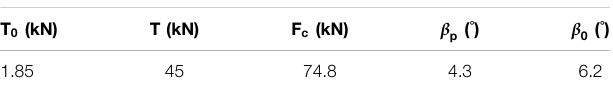
TABLE 2 | Applied boundary conditions in fi nite element model (Lalonde et al., 2018). T 0